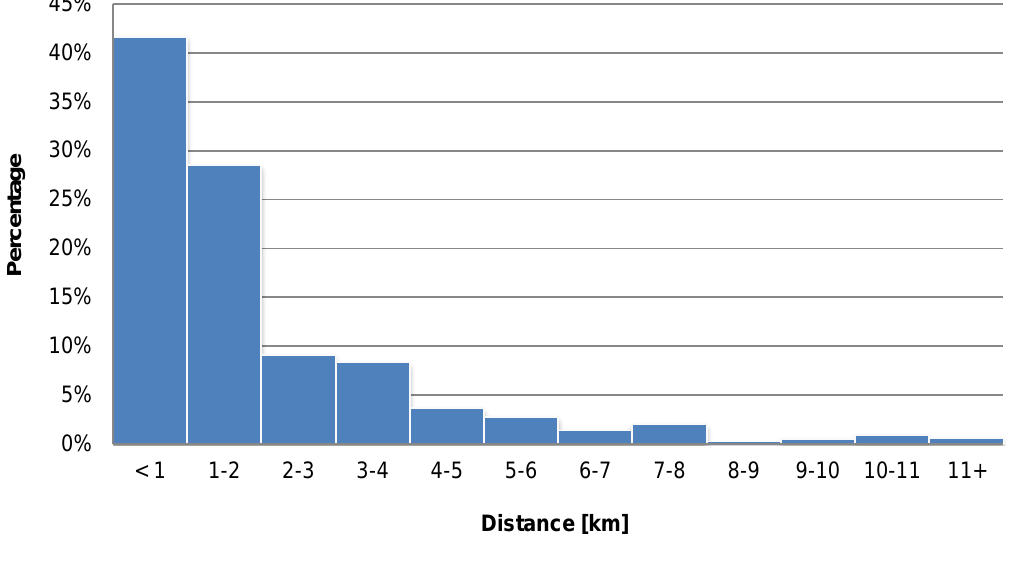
Figure 1. Distribution of the observations over distance